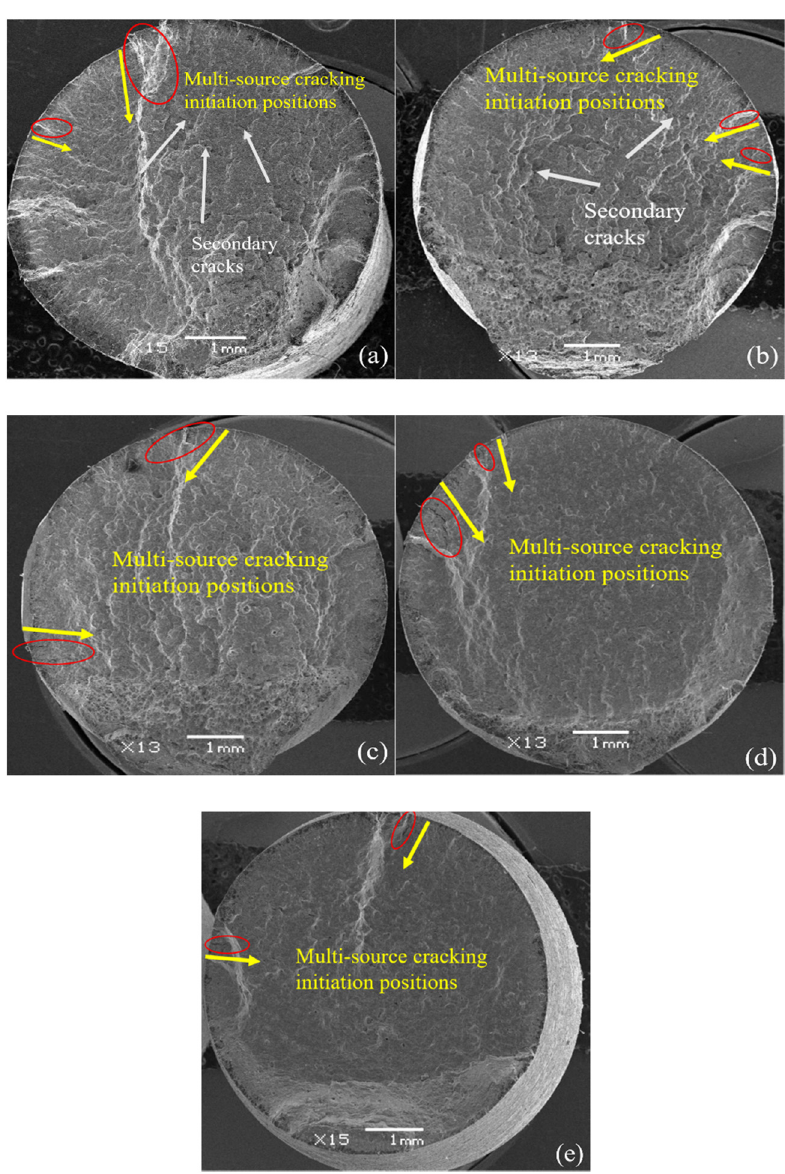
Figure 8: Scanning electron microscope ( SEM ) fractography of specimen under ( a ) IPTMF0.4, 0 s, ( b ) IPTMF0.4, 20 s, ( c ) IPTMF0.4, 40 s, ( d ) IPTMF0.6, 40 s, and ( e ) IPTMF0.8, 40 s